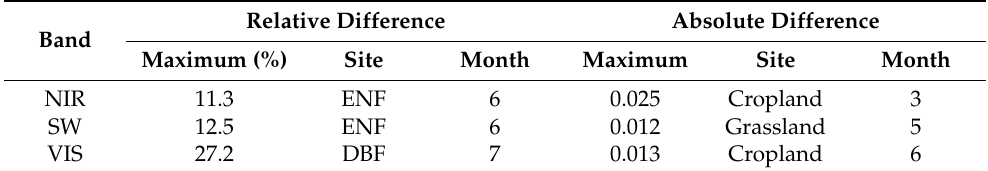
Table 5. Extreme monthly differences in albedo due to BRDF temporal smoothing in all study sites.